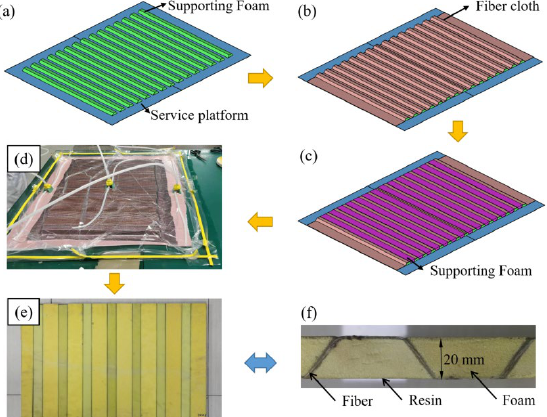
Figure 1. The manufacturing process of the corrugated-core sandwich panel. ( a ) Arranging the bottom foam. ( b ) Laying the fiber cloth. ( c ) Arranging the top foam. ( d ) Injecting the resin. ( e ) The curing of the resin and the molding of the panel. ( f ) Removing the burr on the edge.